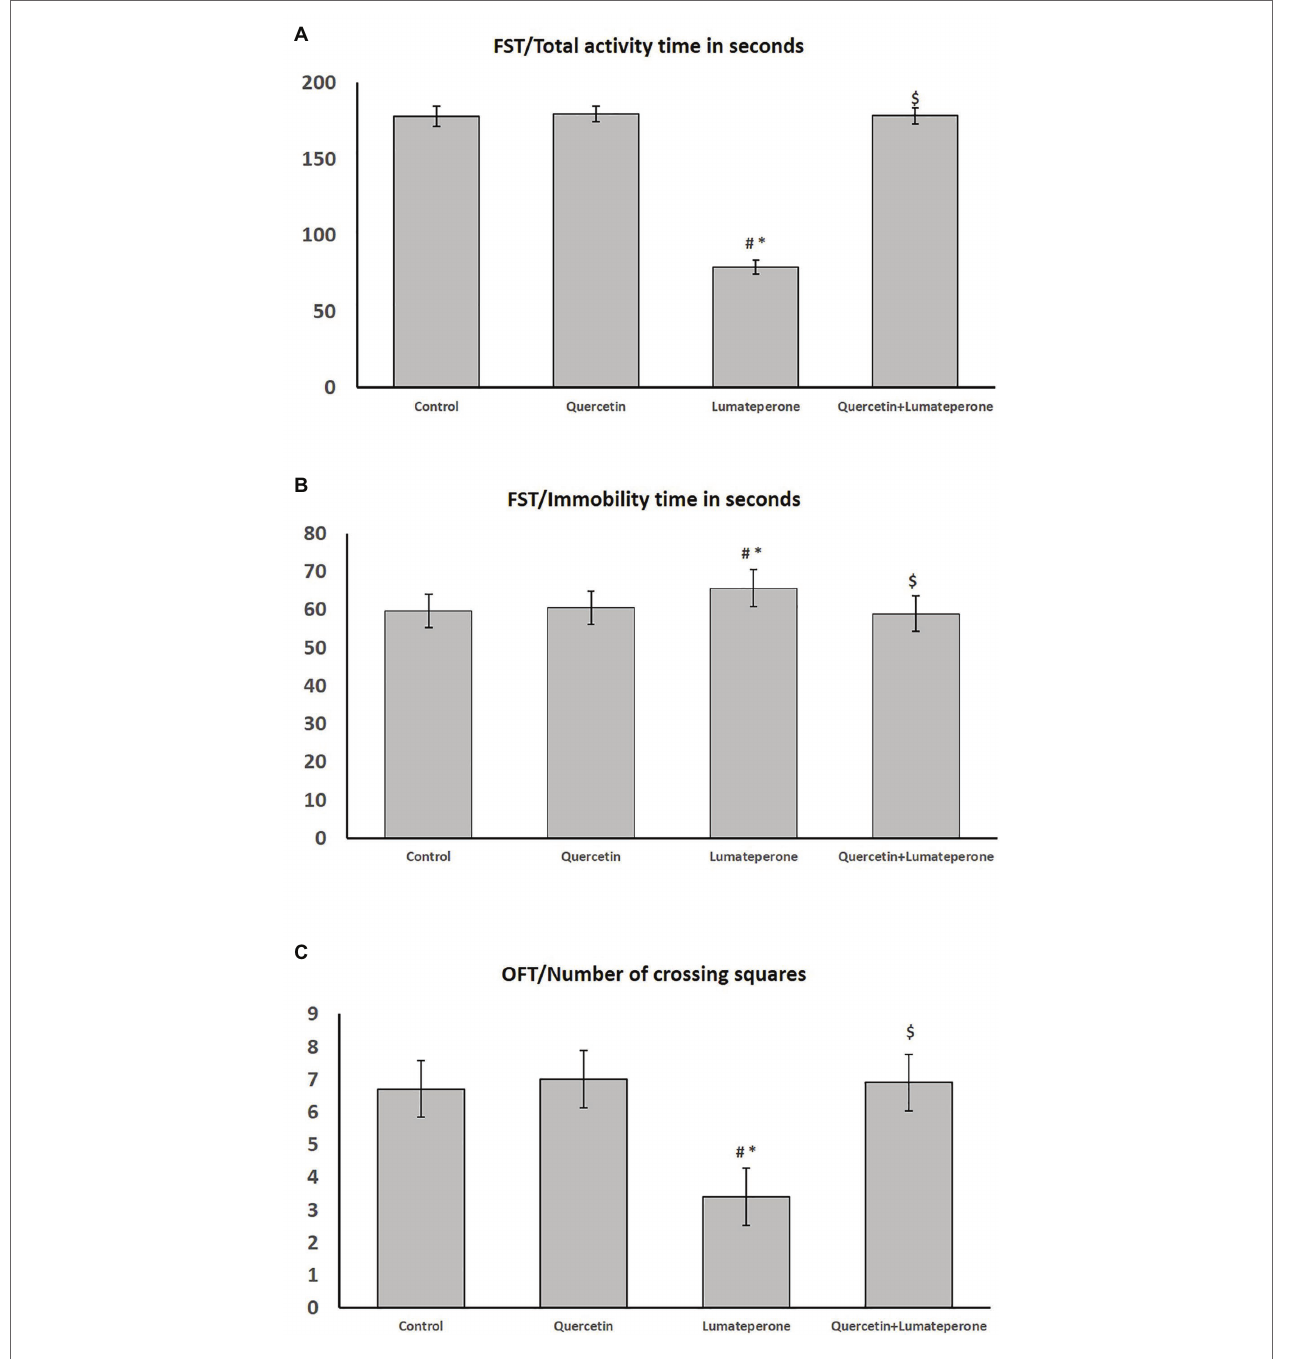
FIGURE 3 | Behavioral test results among control, quercetin, lumateperone, and quercetin/lumateperone-cotreated group; (A) forced swim test (FST) total activity time in second among groups. (B) FST, immobility time in seconds among groups. (C) Open field test (OFT) number of crossing squares among groups. Data were expressed as mean ± SD ( n = 10). One-way ANOVA: # < 0.05 vs. control; ∗ < 0.05631 vs. quercetin; $ < 0.05 vs.